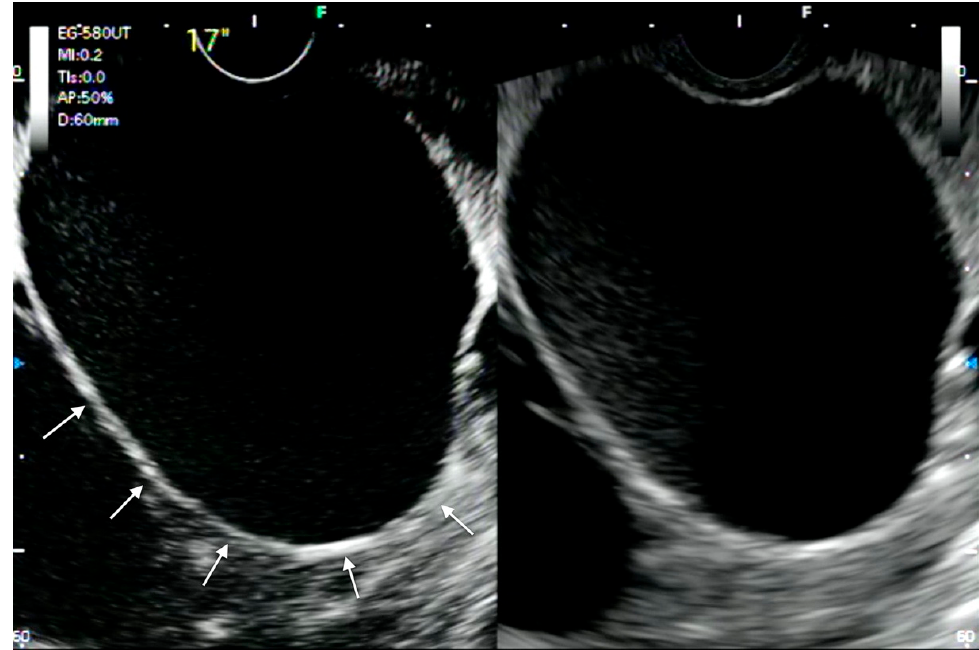
Figure 2. CH-EUS in hepatobiliary evaluation. View of gallbladder wall enhancement (arrows) at CH-EUS evaluation of a hydropic gallbladder.